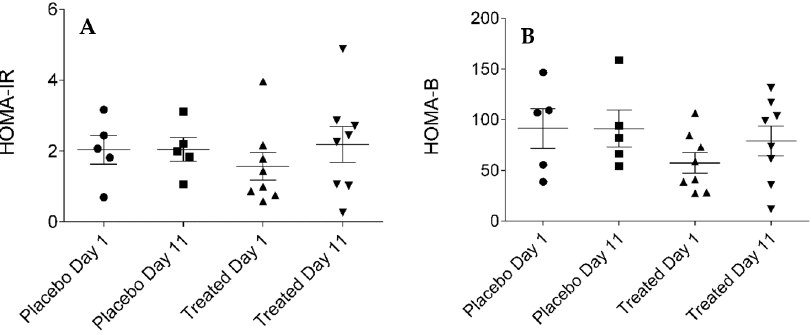
Figure 8. HOMA-IR (homeostatic model assessment-insulin resistance, ( A ) and HOMA-B (homeostatic model assessment-beta cell function, ( B ) of the placebo- and fenugreek-treated subjects.